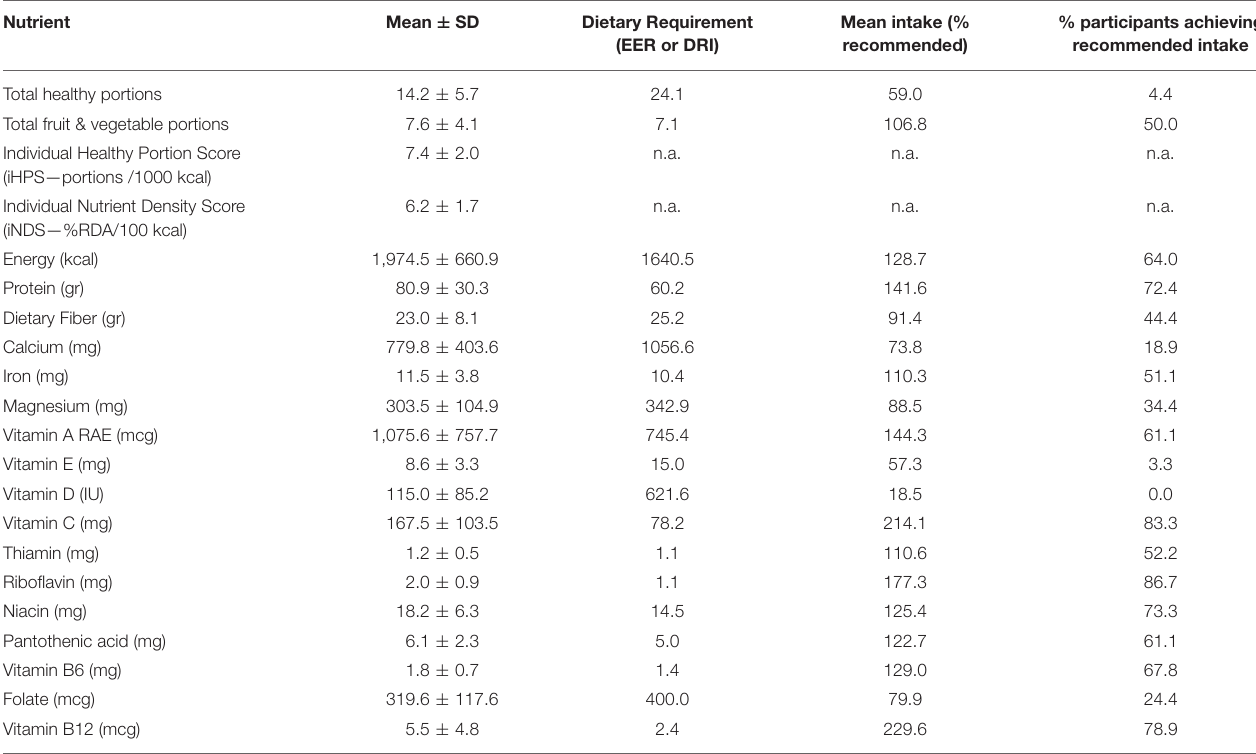
TABLE 4 | Quality of habitual individual dietary intake as assessed by Food Frequency Questionnaire (FFQ).